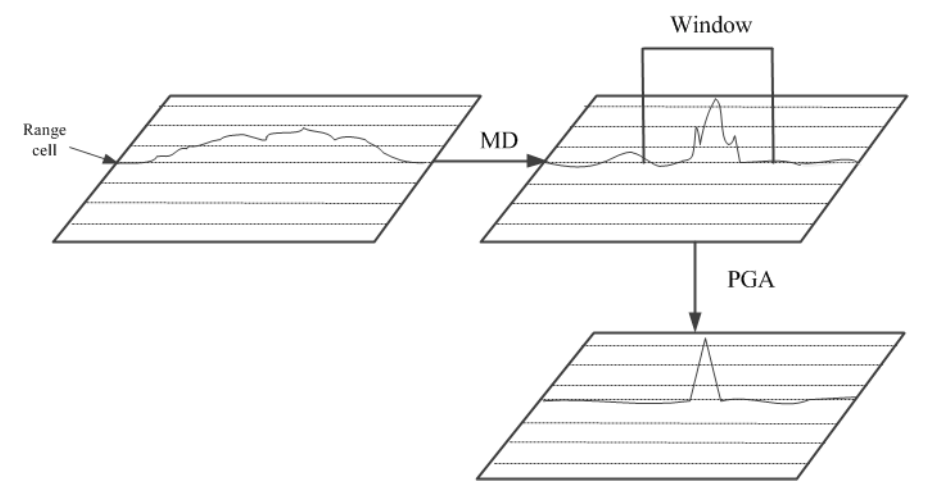
Figure 9. Apply MD algorithm before PGA.